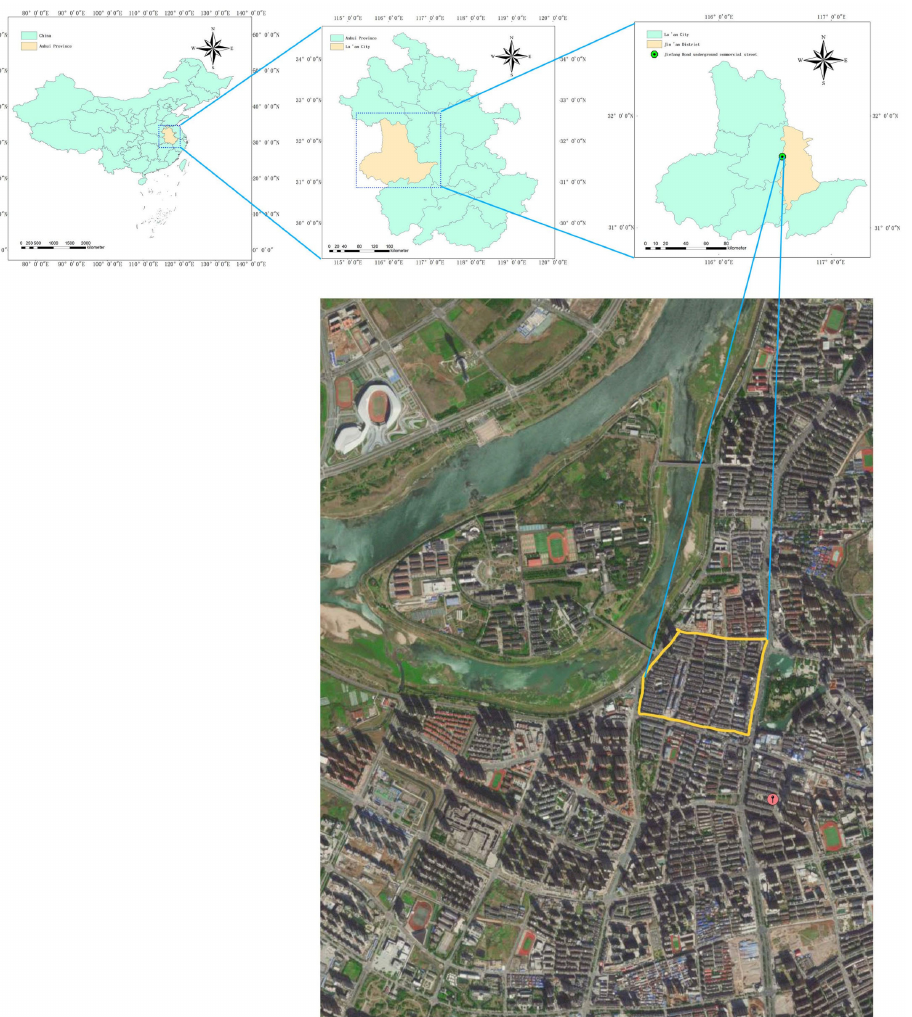
Figure 1. Study area and sampling sites in Lu’an